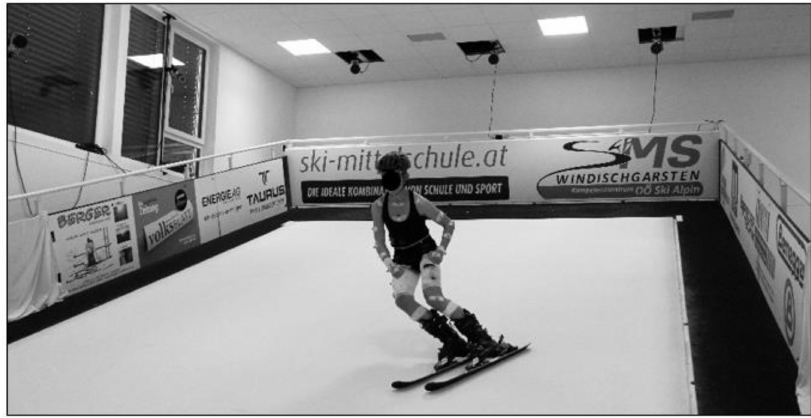
Figure 1. Illustration of the experiment configuration in the indoor skiing